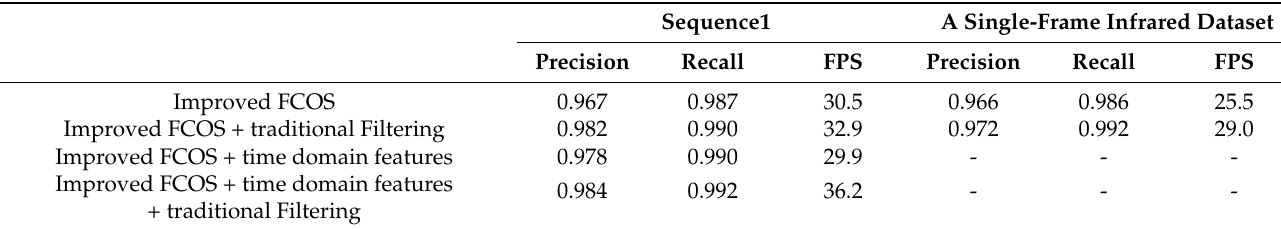
Table 3. Comparative experiment results between the improved FCOS and comprehensive method for sequence1 and the single-frame infrared dataset.